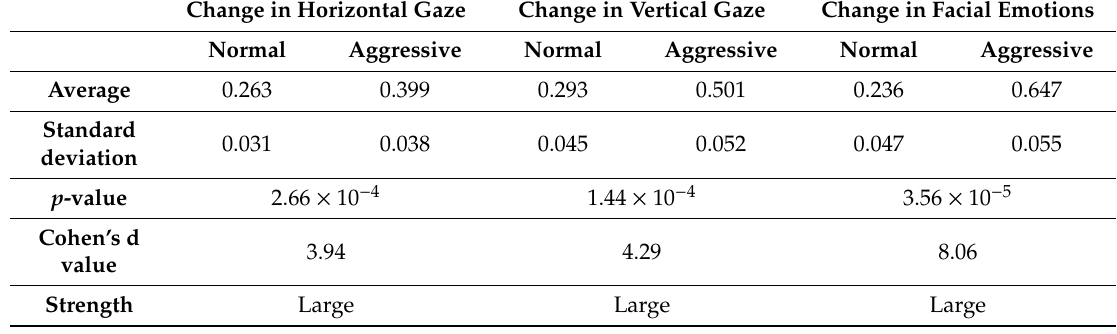
Table 4. p -value, Cohen’s d value, and effect size of five features between normal and aggressive driving. Change in Horizontal Gaze Change in Vertical Gaze Change in Facial Emotions